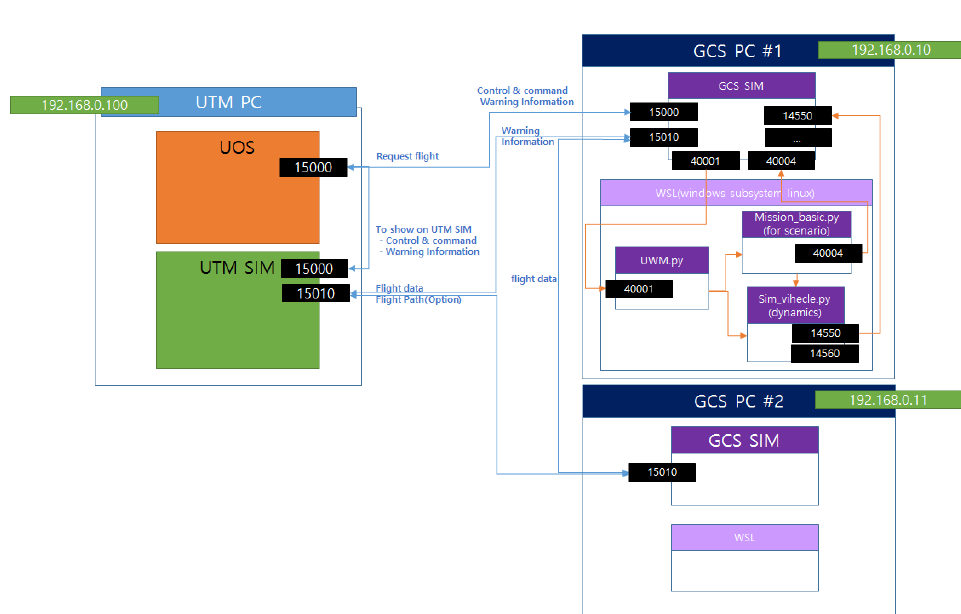
Figure 8. Overall system configuration of eUTM.